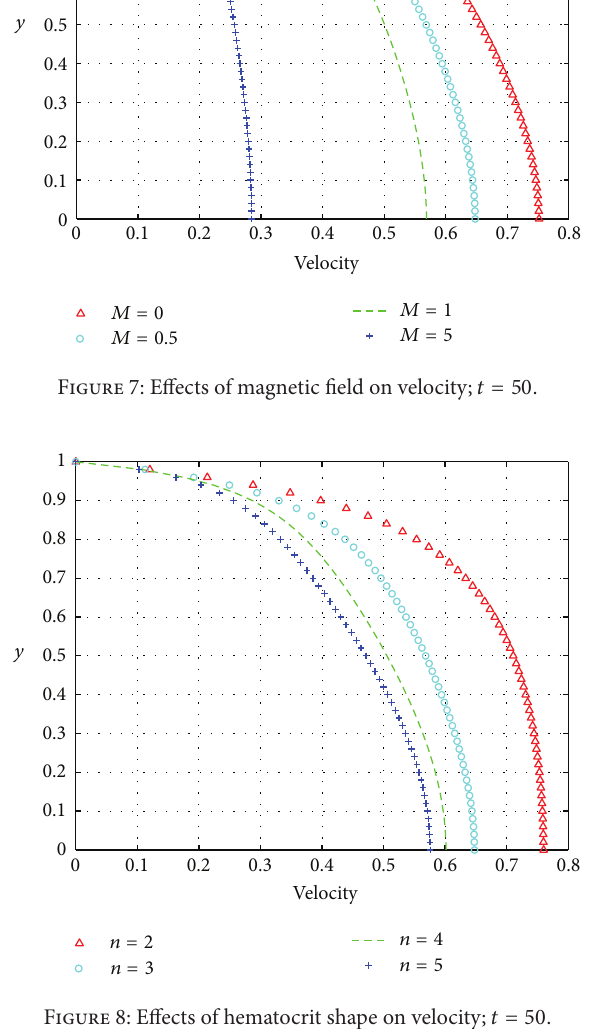
Figure 8: Effects of hematocrit shape on velocity; 𝑡 = 50 .